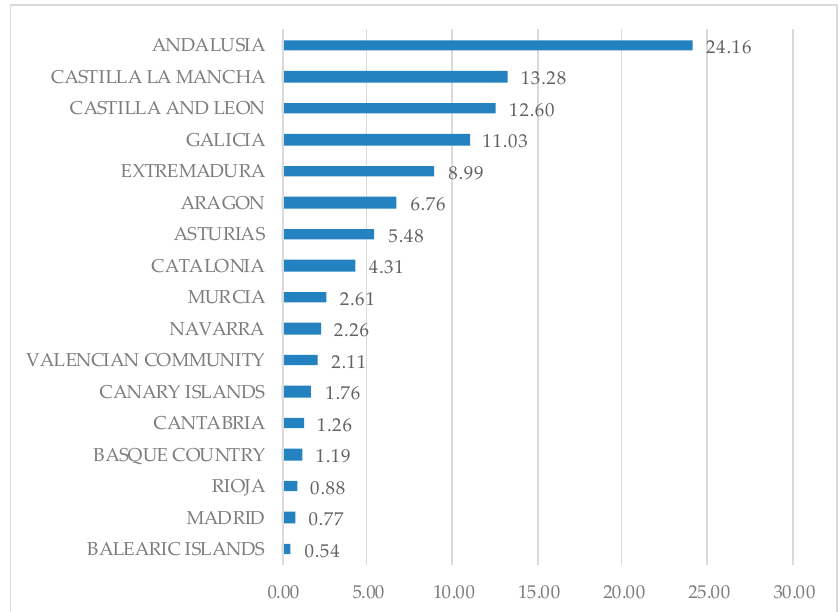
Figure 2. EAFRD percentage distribution for the period 2007–2013 (Source: Own elaboration from data published by the Ministry of Agriculture, Fisheries, and Food).